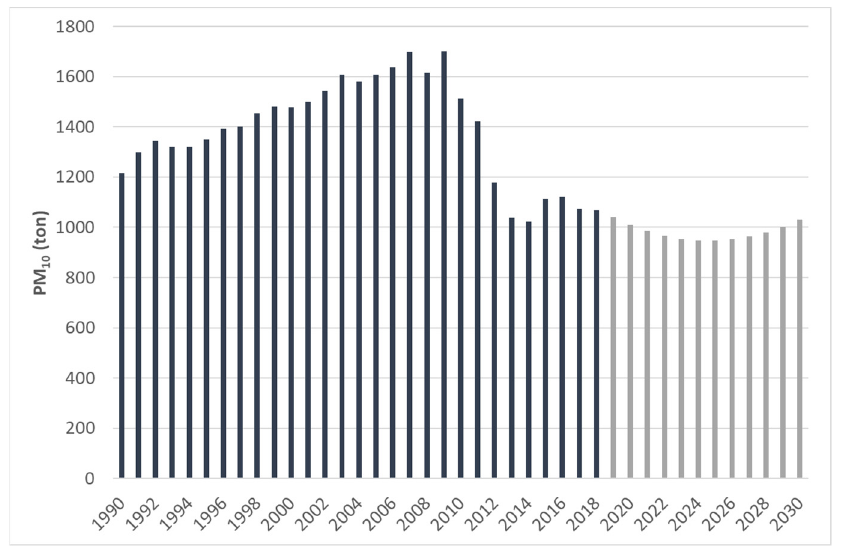
Figure 15. Total PM 10 emissions from passenger cars in Greece for the period 1990–2030 including the non-exhaust PM 10 (tyre and brake wear, road abrasion).